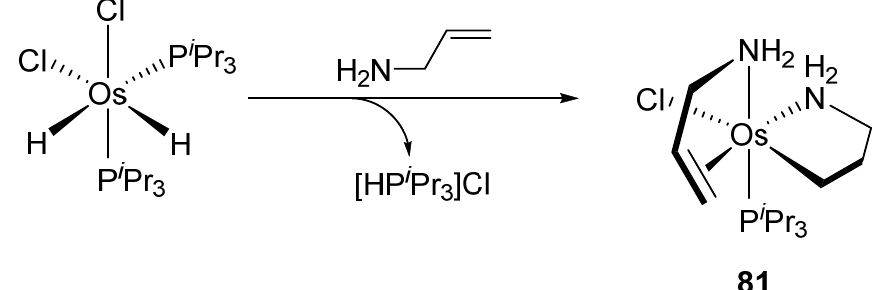
Figure 15. Reaction between [OsH 2 Cl 2 (P i Pr 3 ) 2 ] and allylamine.